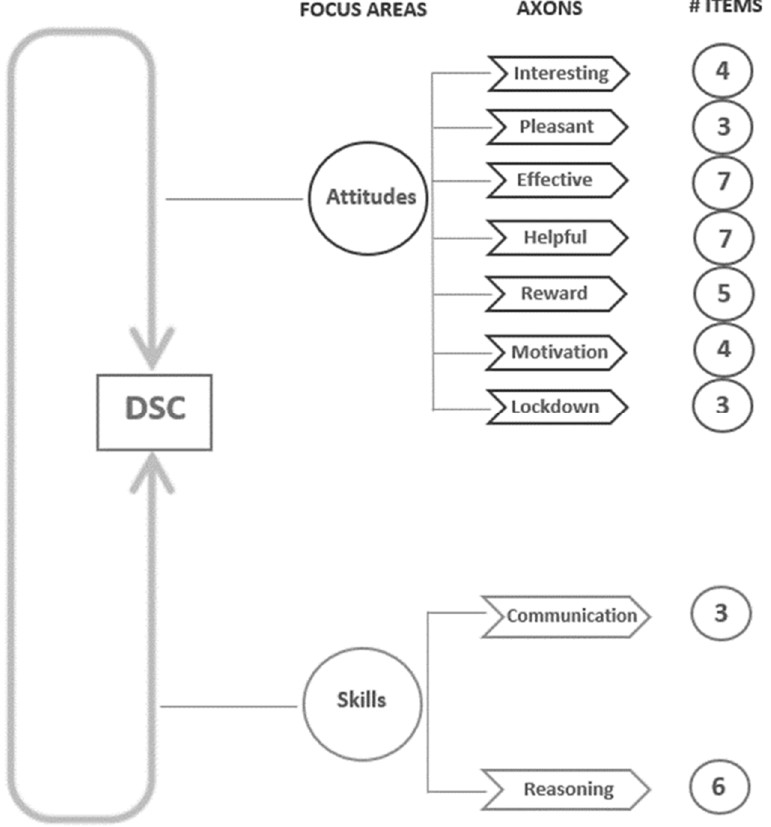
Figure 1. Research parts of the DSC questionnaire.